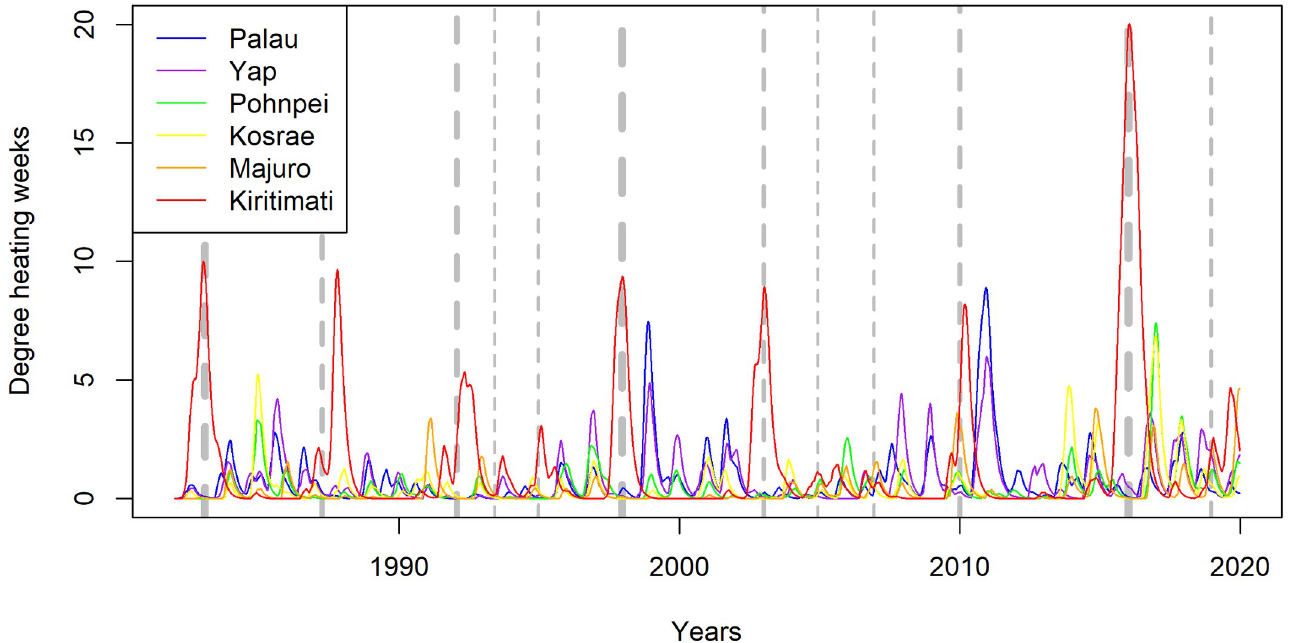
Fig 2. A time series of thermal stress in the Pacific Ocean from 1982 to 2020 at Palau, Yap, Pohnpei, Kosrae, Majuro, and Kiritimati, expressed as degree heating weeks (DHWs), which is the cumulative measure of the intensity and duration of heat stress that exceeds the average summertime maximum temperature (i.e., local climatology) by 1˚C, culminated over 12 weeks and expressed in the unit ˚C-weeks. The timing of El Ni ñ o events are indicated with vertical dashed lines and the thickness of the lines are in proportion to the intensity of the event.